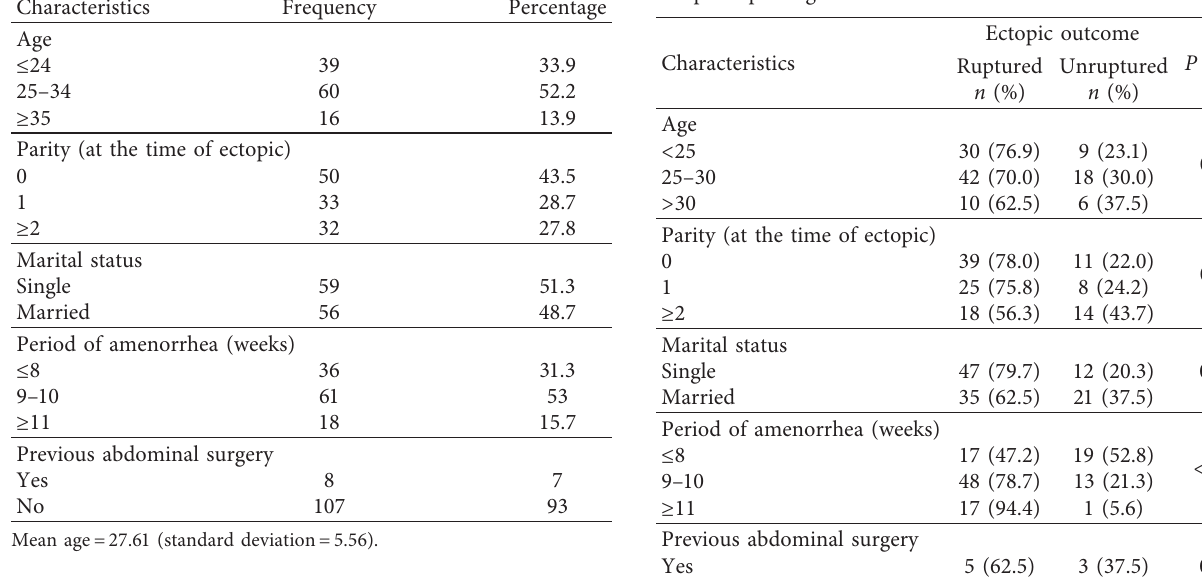
Table 2: Relationship between participant’s characteristics and ectopic rupturing.